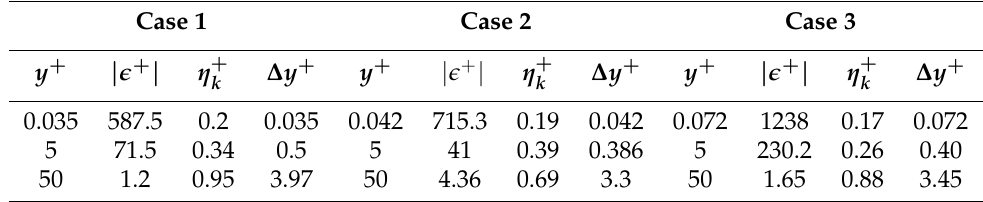
Table A1. Kolmogorov length scales at x / D = 0.5.